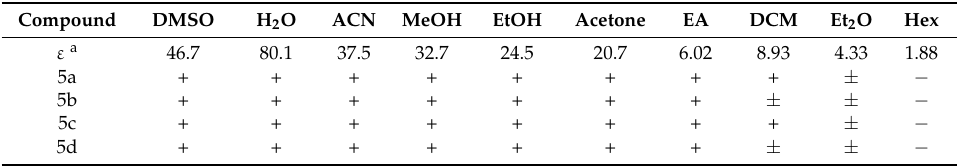
Table 2. Comparison of B-L MIL solubility in various organic solvents (+: soluble, ± : slightly soluble, − : insoluble) (full names of organic solvents are shown in Section 2.1 Chemicals). Compound DMSO H 2